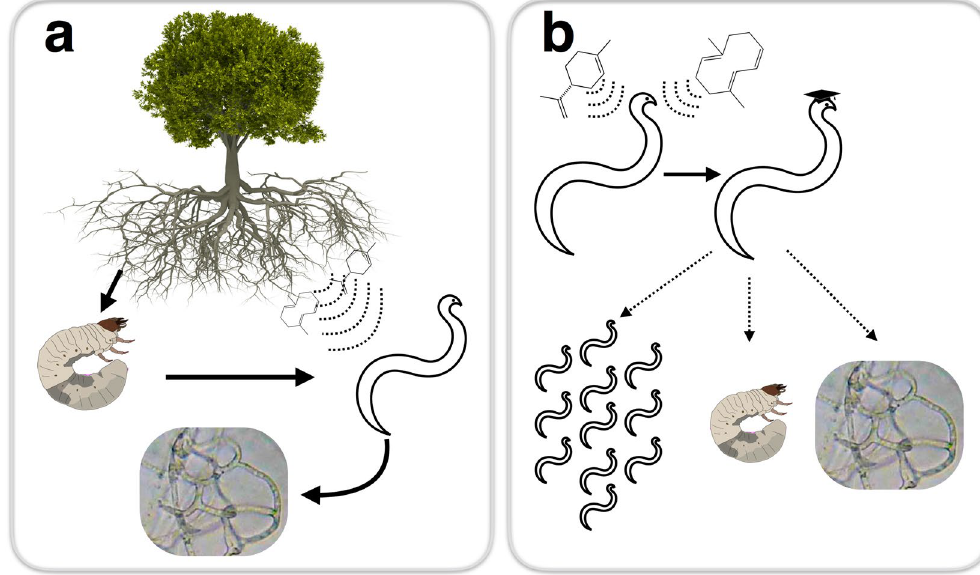
Figure 1. Belowground Multitrophic Interactions. ( a ) In the field, citrus roots are fed upon by larvae of the weevil D . abbreviatus . Entomopathogenic nematodes, parasitoids of insect larvae, respond to volatile terpene compounds released by roots following stimulation of plant defenses. Nematophagous fungi capture and consume entomopathogenic nematodes. ( b ) To determine the multitrophic effects of belowground parasitoid learning, entomopathogenic nematodes were exposed to volatiles they encounter in a belowground environment. These exposed, ‘educated’, entomopathogenic nematodes were then assayed to determine effects on other entomopathogenic nematodes, host insects, and nematophagous fungi. Citrus tree ©Can Stock Photo Inc. Insect larva courtesy BugBoy 52.40. Fungal hyphae courtesy Bob